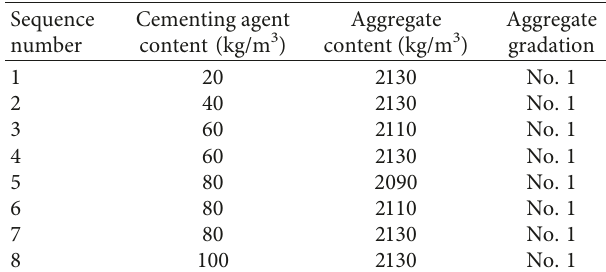
Table 2: Test programs on Material I to investigate effects of cementing agent content and aggregate